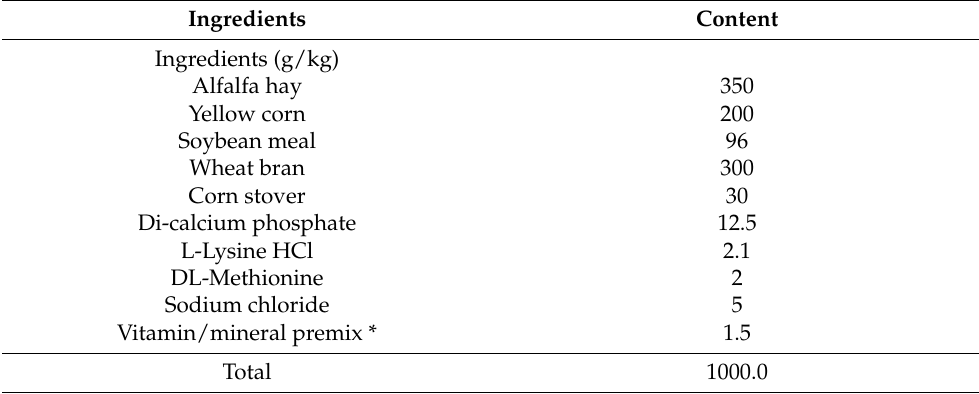
Table 1. Composition and calculated analyses of the basal diet (g/kg, as-fed basis) of weaned